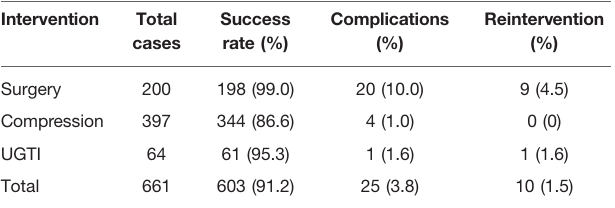
TABLE 4 | Summary of outcomes.